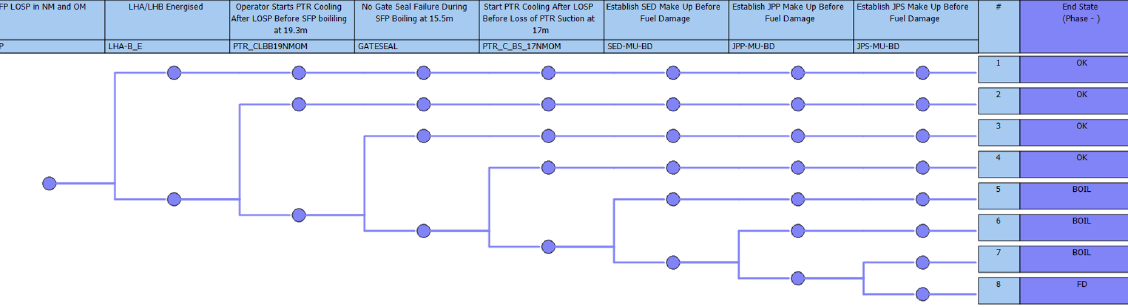
Figure 4. Event tree model of LOSP.